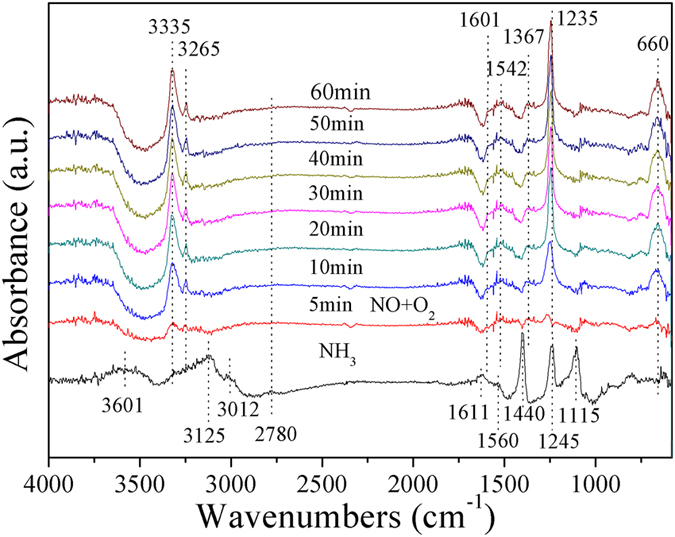
In situ DRIFTS spectra over Cu1Bi1-mBeta catalyst at 250 °C.